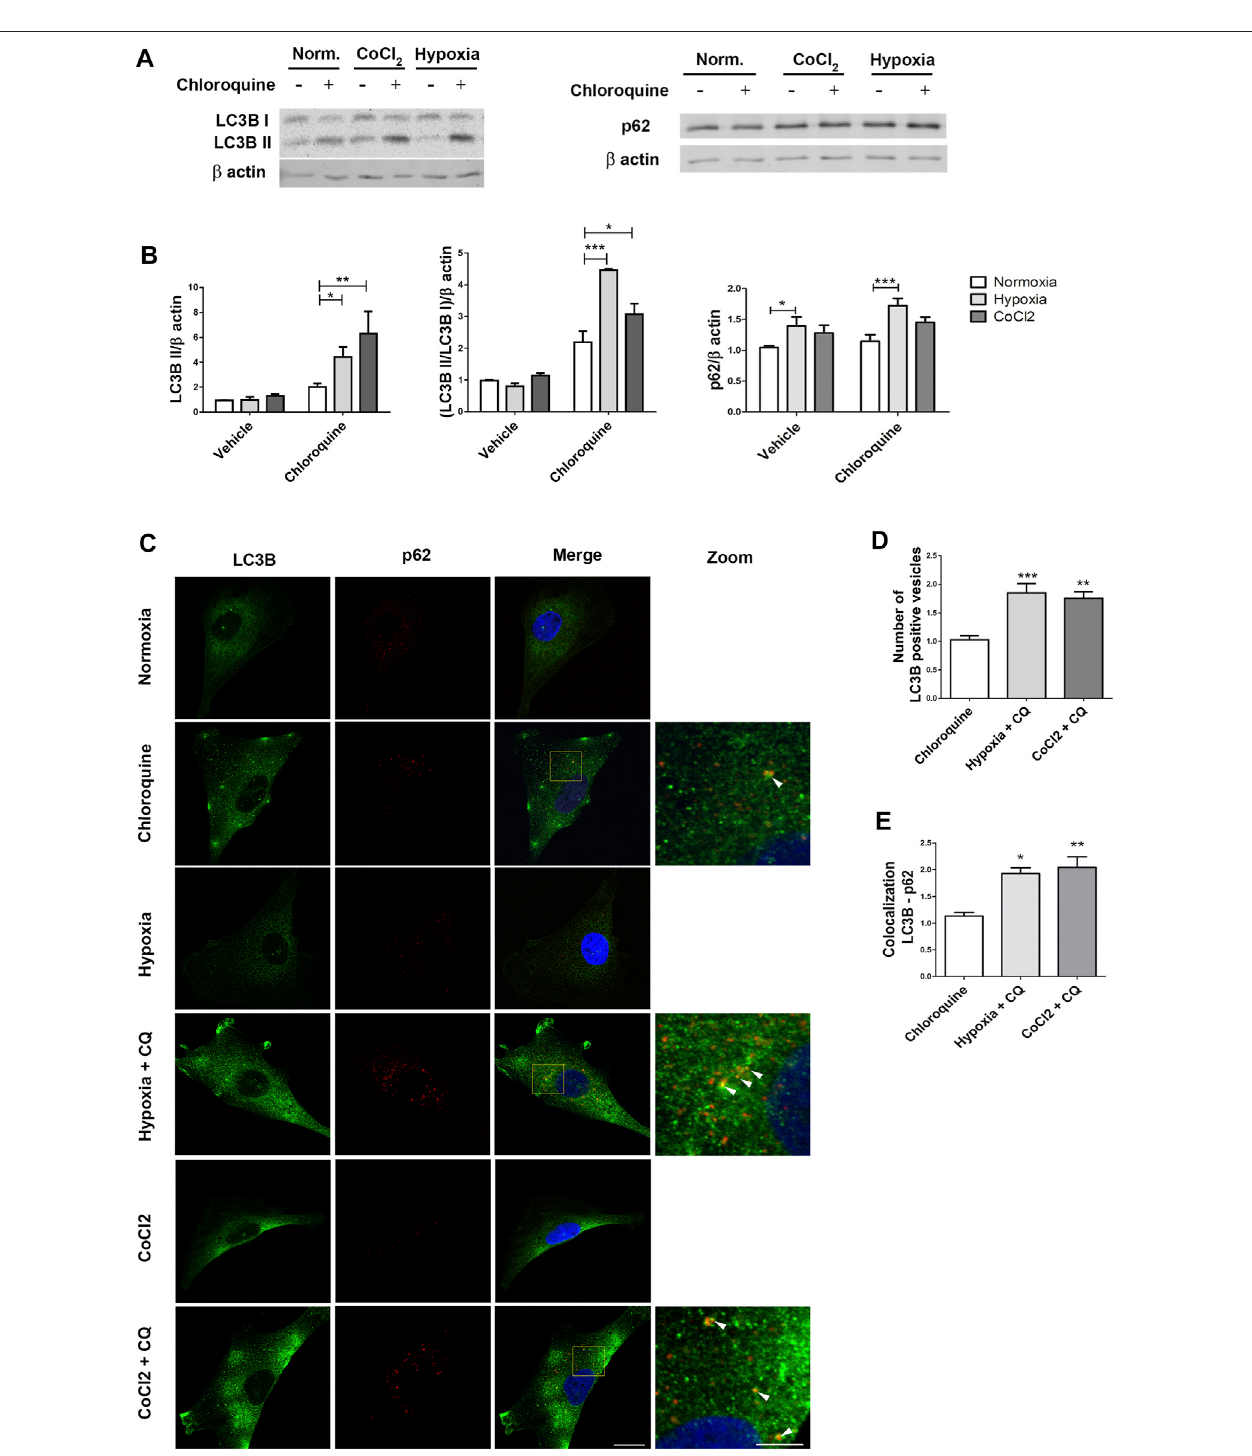
FIGURE 2 | Hypoxia increases LC3B II and p62 protein levels in MIO-M1. (A) Representative Western blot of autophagy markers, LC3B II and p62, from cellular lysatesofMIO-M1incubatedinhypoxicconditions:gas(1%O 2 )orchemicalhypoxia(250 mMCoCl 2 )during4 h. (B) ProteinlevelsofLC3BIIandp62werequanti fi edby densitometry and normalized to β actin. Graph shows results of three independent experiments. (C) Representative immuno fl uorescence analysis of LC3B (green) and p62 (red) in MIO-M1 cells incubated in hypoxic conditions: gas (1% O 2 ) or CoCl 2 (250 mM) during 4 h. Cell nuclei were counterstained with Hoechst 33258 (blue). Images were taken with oil 60X objective in the best confocal resolution condition. (D) Quanti fi cation of LC3B puncta per cell with ImageJ analyze particles software. Values were normalized to normoxia + chloroquine. (E) Quanti fi cation of LC3B/p62 colocalization with ImageJ JACoP software. Pearson values were compared statistically. Values were normalized to normoxia + chloroquine. Statistical t test was performed. White arrows in the images show mayor colocalization areas. Data is presented as mean ± SEM. * p < 0.05, ** p < 0.01, *** p < 0.001. Graph shows results of three independent experiments.